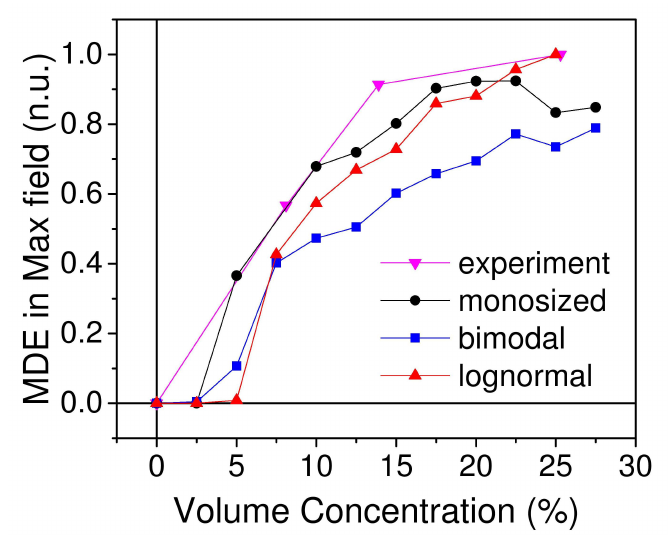
Figure 11. Volume concentration dependence of maximal MDE value for three types of size distribution compared to experimental data. Max field is equal to 955 kA/m.